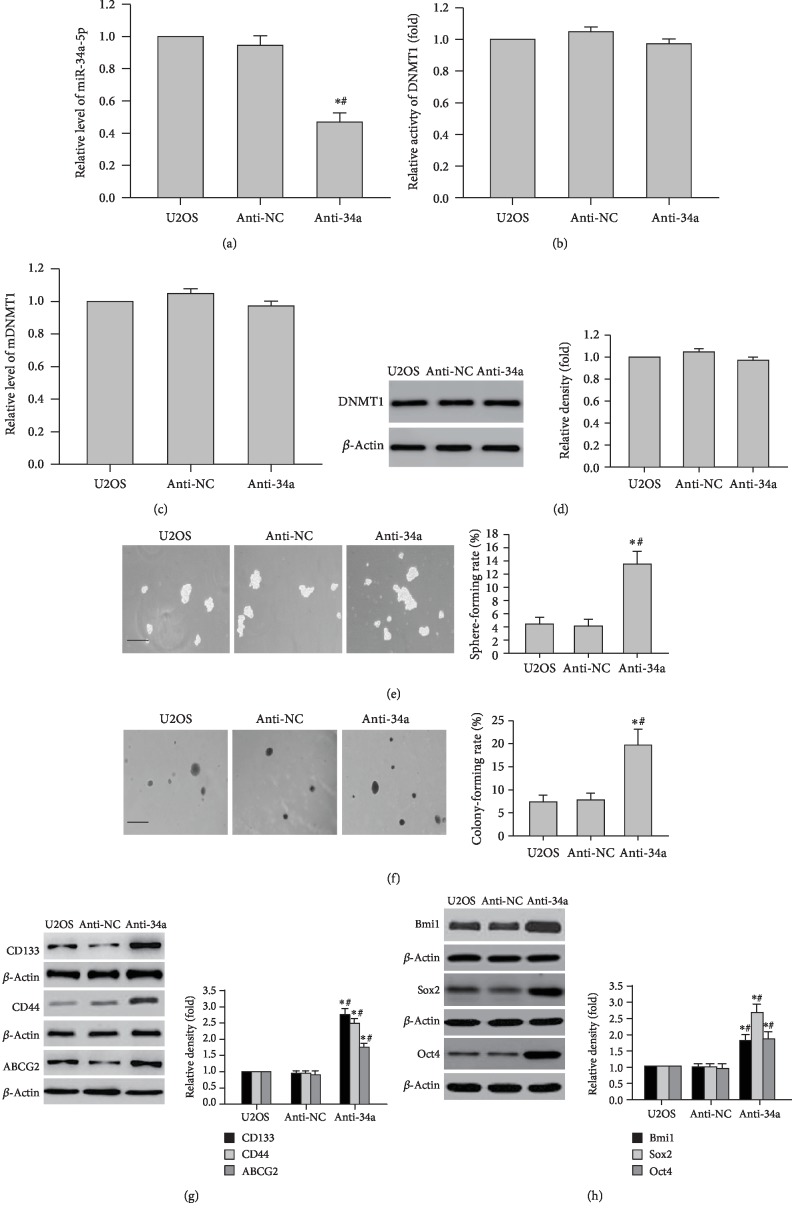
Effects of the miR-34a-5p inhibitor on the stemness feature in U2OS cells. (a) qRT-PCR analyzed the levels of miR-34a-5p in U2OS cells transfected with anti-NC or miR-34a inhibitor (anti-34a). ∗p < 0.05 (n = 3) vs. U2OS cells; #p < 0.05 (n = 3) vs. anti-NC. (b, c) ELISA and qRT-PCR detected DNMT1 activities and mRNA in U2OS cells transfected with anti-NC or anti-34a. (d) Immunoblot analyzed the DNMT1 expression in U2OS cells transfected with anti-NC or anti-34a, with β-actin serving as a loading control. (e) Representative images of the spheres of U2OS cells transfected with anti-34a or with anti-NC and untreated U2OS cells serving as the controls (left) (scale bar, 200 μm) and the sphere-forming rates (right). (f) Representative images of the colony formation of U2OS cells transfected with anti-34a or with anti-NC and untreated U2OS cells serving as the controls (left) (scale bar, 200 μm) and the colony-forming rates (right). (g) CD133, CD44, and ABCG2 proteins in U2OS cells transfected with anti-34a or with anti-NC and untreated U2OS cells serving as the controls (left) and their densitometric analysis (right). (h) Bmi1, Sox2, and Oct4 of U2OS cells transfected with anti-34a or with anti-NC and untreated U2OS cells serving as the controls. ∗p < 0.05 (n = 3) vs. U2OS cells; #p < 0.05 (n = 3) vs. U2OS cells transfected with anti-NC.